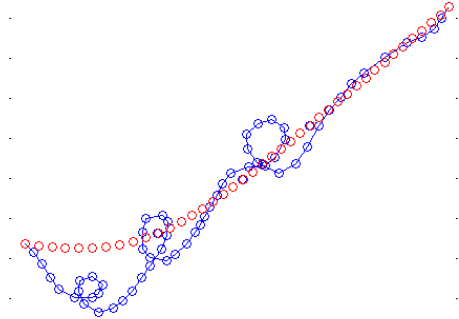
Figure 4 A curve with « loops » (blue) and the smoothed curve (red).